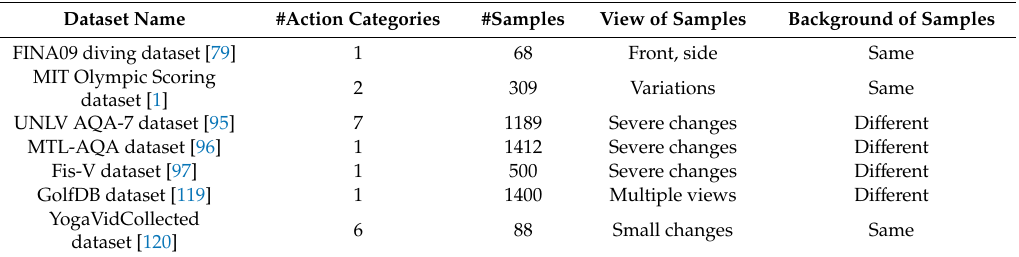
Table 3. Sports activity scoring